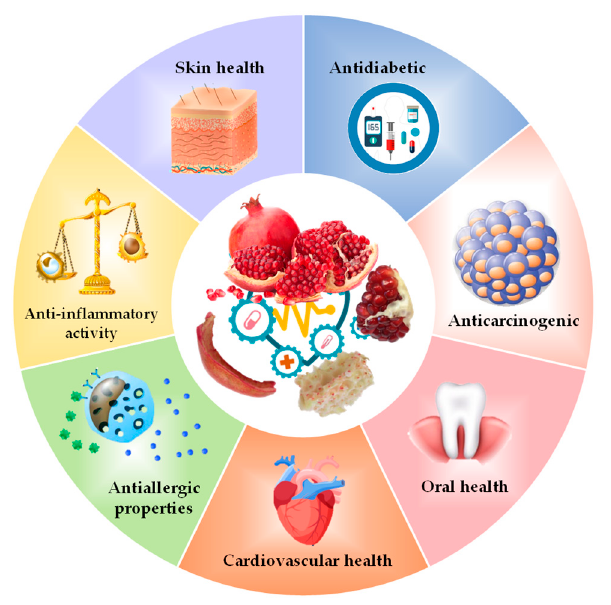
Figure 2. Health benefits associated with pomegranate by-products.